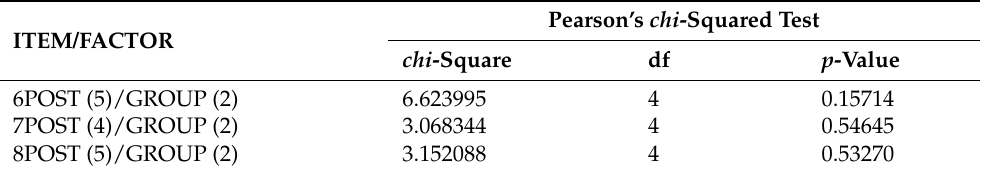
Table 6. Results of the chí -squared test of the independence of the questionnaire nominal items according to the GROUP factor.